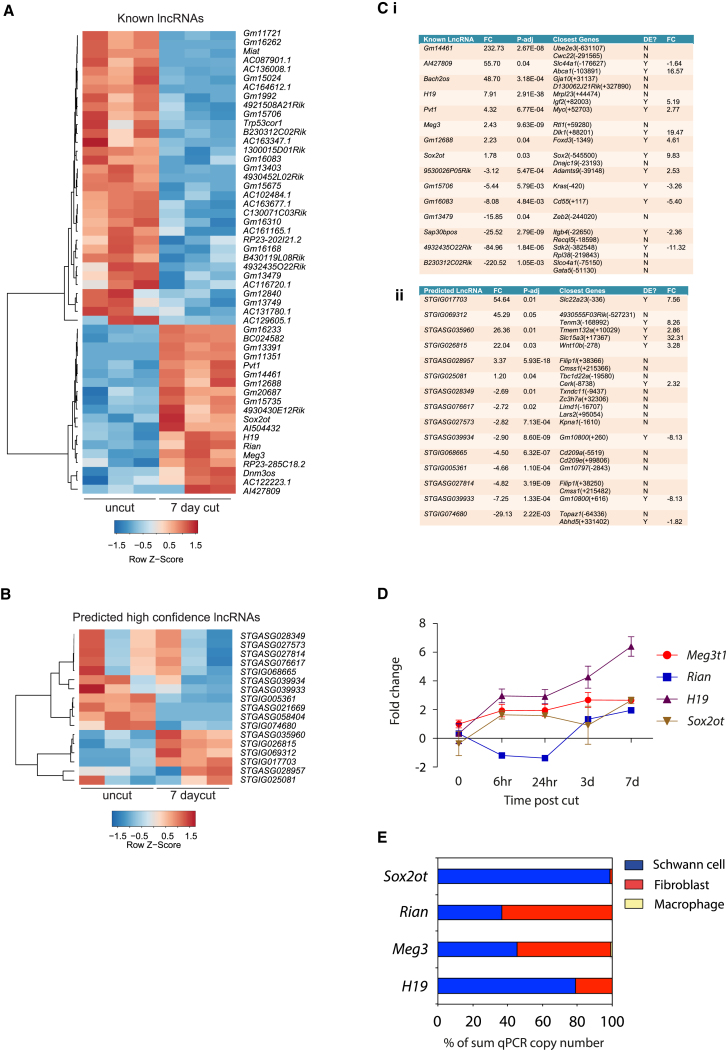
lncRNA Expression after Nerve Injury(A) A heatmap of the 52 annotated DE lncRNAs between uncut and 7-day cut sciatic nerve from RNA-seq experiments (p-adj < 0.05).(B) A heatmap of the 17 predicted DE lncRNAs between uncut and 7-day cut sciatic nerve from RNA-seq experiments (p-adj < 0.05).(C) Table of selected known (i) and predicted (ii) lncRNAs, with fold change (FC) and p-adj values from the RNA-seq study along with their closest genes, whether they are also differentially expressed (DE?) in the RNA-seq study, and the corresponding fold change.(D) Time course of expression of the lncRNAs, Meg3 (t1 = transcript 1), Rian, H19, and Sox2ot after sciatic nerve cut by qPCR (n = 4). Fold change is relative to the uncut nerve. Error bars represent SEM.(E) Relative cell type expression of Meg3 (transcript 1), Rian, H19, and Sox2ot in cultured mouse Schwann cells (blue), nerve fibroblasts (red), and activated macrophages (yellow) displayed as percentage of the sum of qPCR copy-number values from 1ug of RNA from each of the three cell types (n = 3).